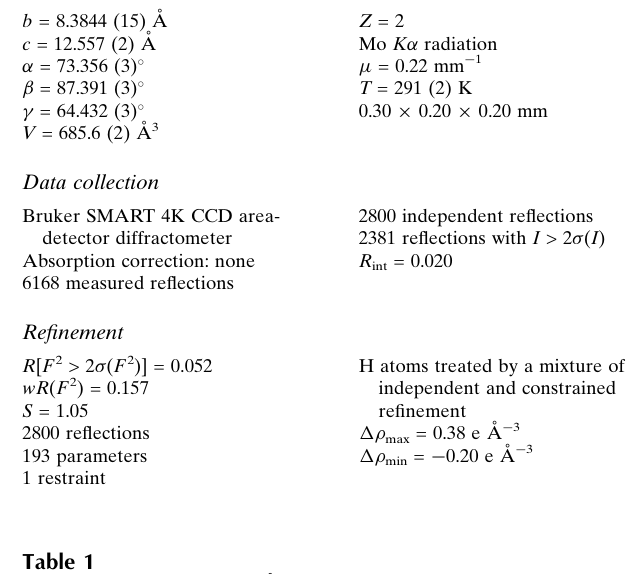
Hydrogen-bond geometry (A˚ , (cid:1)